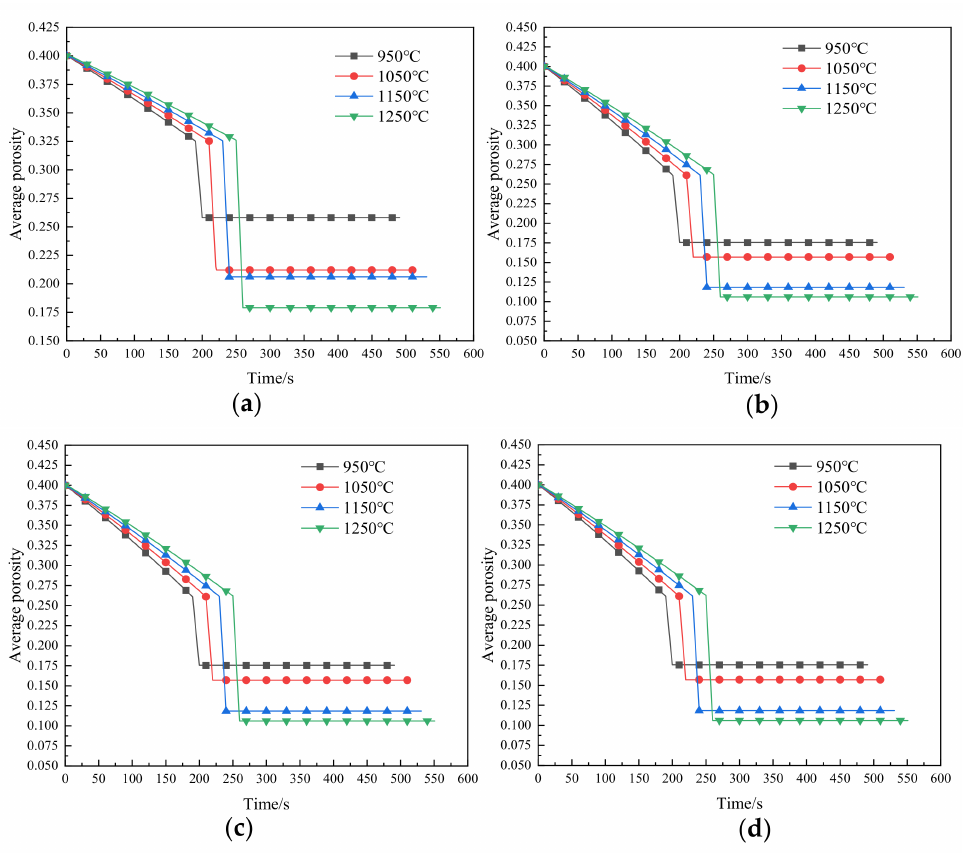
Figure 5. Effect of sintering temperature on porosity under various sintering pressures: ( a ) 50 MPa; ( b ) 70 MPa; ( c ) 90 MPa; ( d ) 110